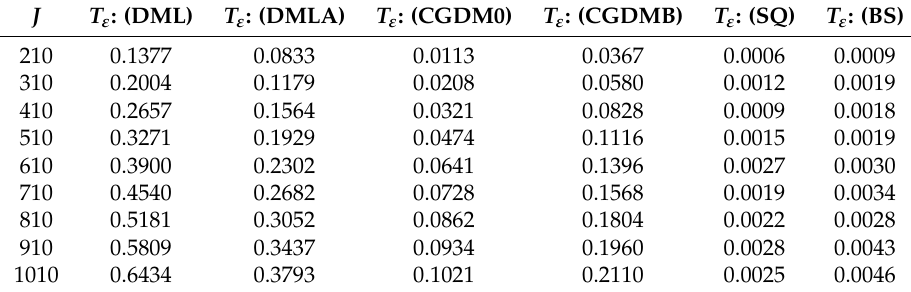
Table 8. Results for Case Q with m = 25, ε = 10 − 2 .